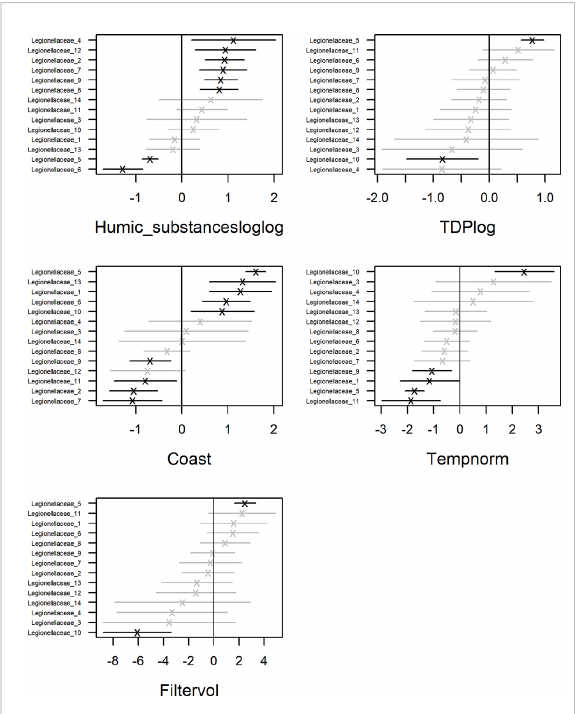
FIGURE 8 Coef fi cient estimates by GLLVM analysis showing average effect and uncertainty (as 95% CI) for each organismal